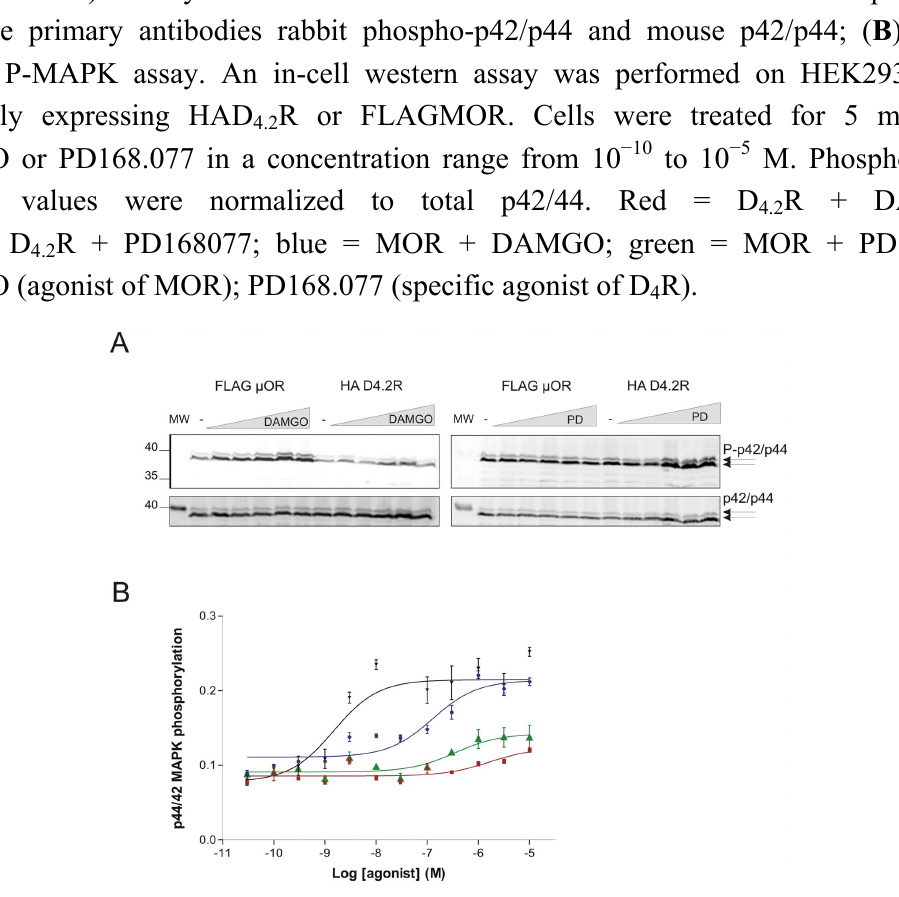
Figure S1. Specificity PD168,077 for dopamine D receptor. ( A ) Western blot analysis of 4 R or FLAGMOR MAPK phosphorylation. HEK293T cells transiently expressing HAD 4.2 were treated for 5 min with different concentrations of DAMGO or PD168.077 (PD) (10 − 9 to 10 − 5 M). Cell lysates were made and a Western immunoblot with was performed using the primary antibodies rabbit phospho-p42/p44 and mouse p42/p44; ( B ) In-cell western P-MAPK assay. An in-cell western assay was performed on HEK293T cells transiently expressing HAD R or FLAGMOR. Cells were treated for 5 min with 4.2 DAMGO or PD168.077 in a concentration range from 10 − 10 to 10 − 5 M. Phosphorylated